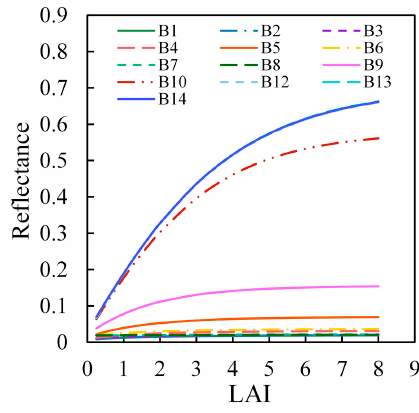
Figure 4. Sensitivity of spectra to LAI.